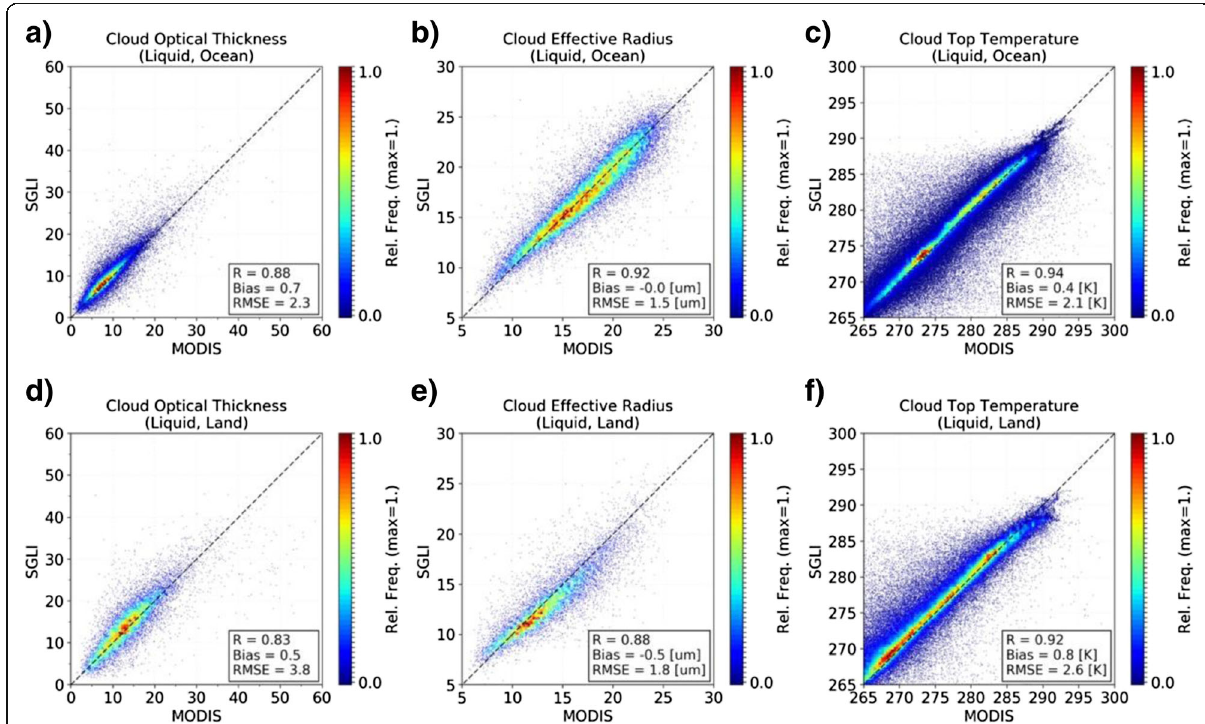
Fig. 17 Scatter plots of a , d optical thickness, b , e effective radius, and c , f top temperature for water clouds from the SGLI retrievals compared with the MOD06 retrievals. Panels ( a – c ) are for ocean and ( d – f ) are for